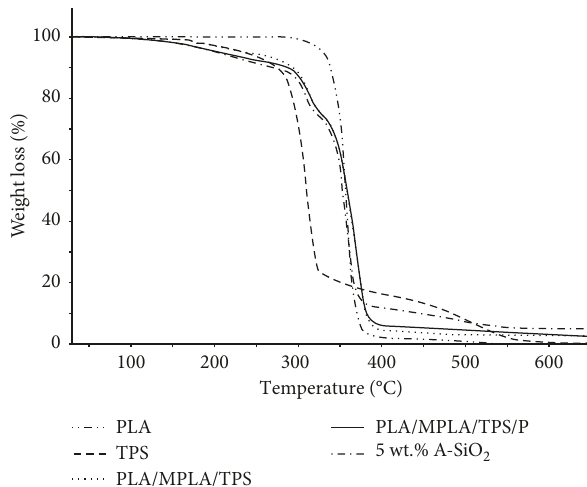
Figure 9: TGA curves of PLA, TPS, and various blends and